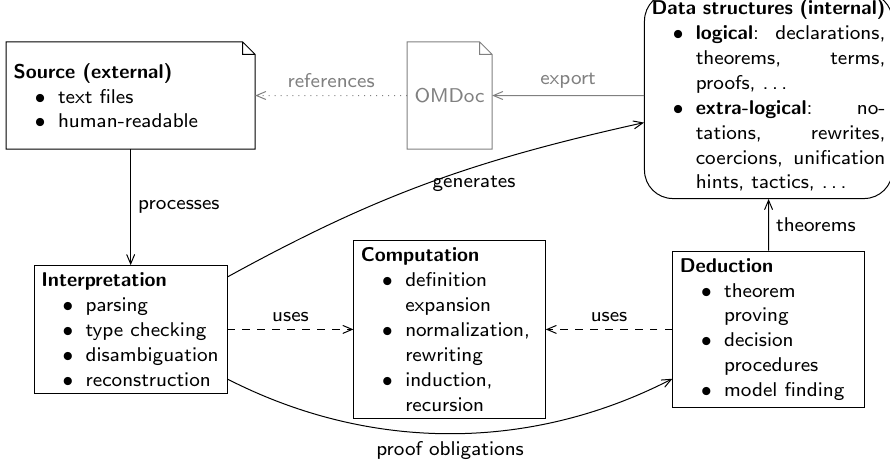
Fig. 1. Typical Architecture of a Deduction